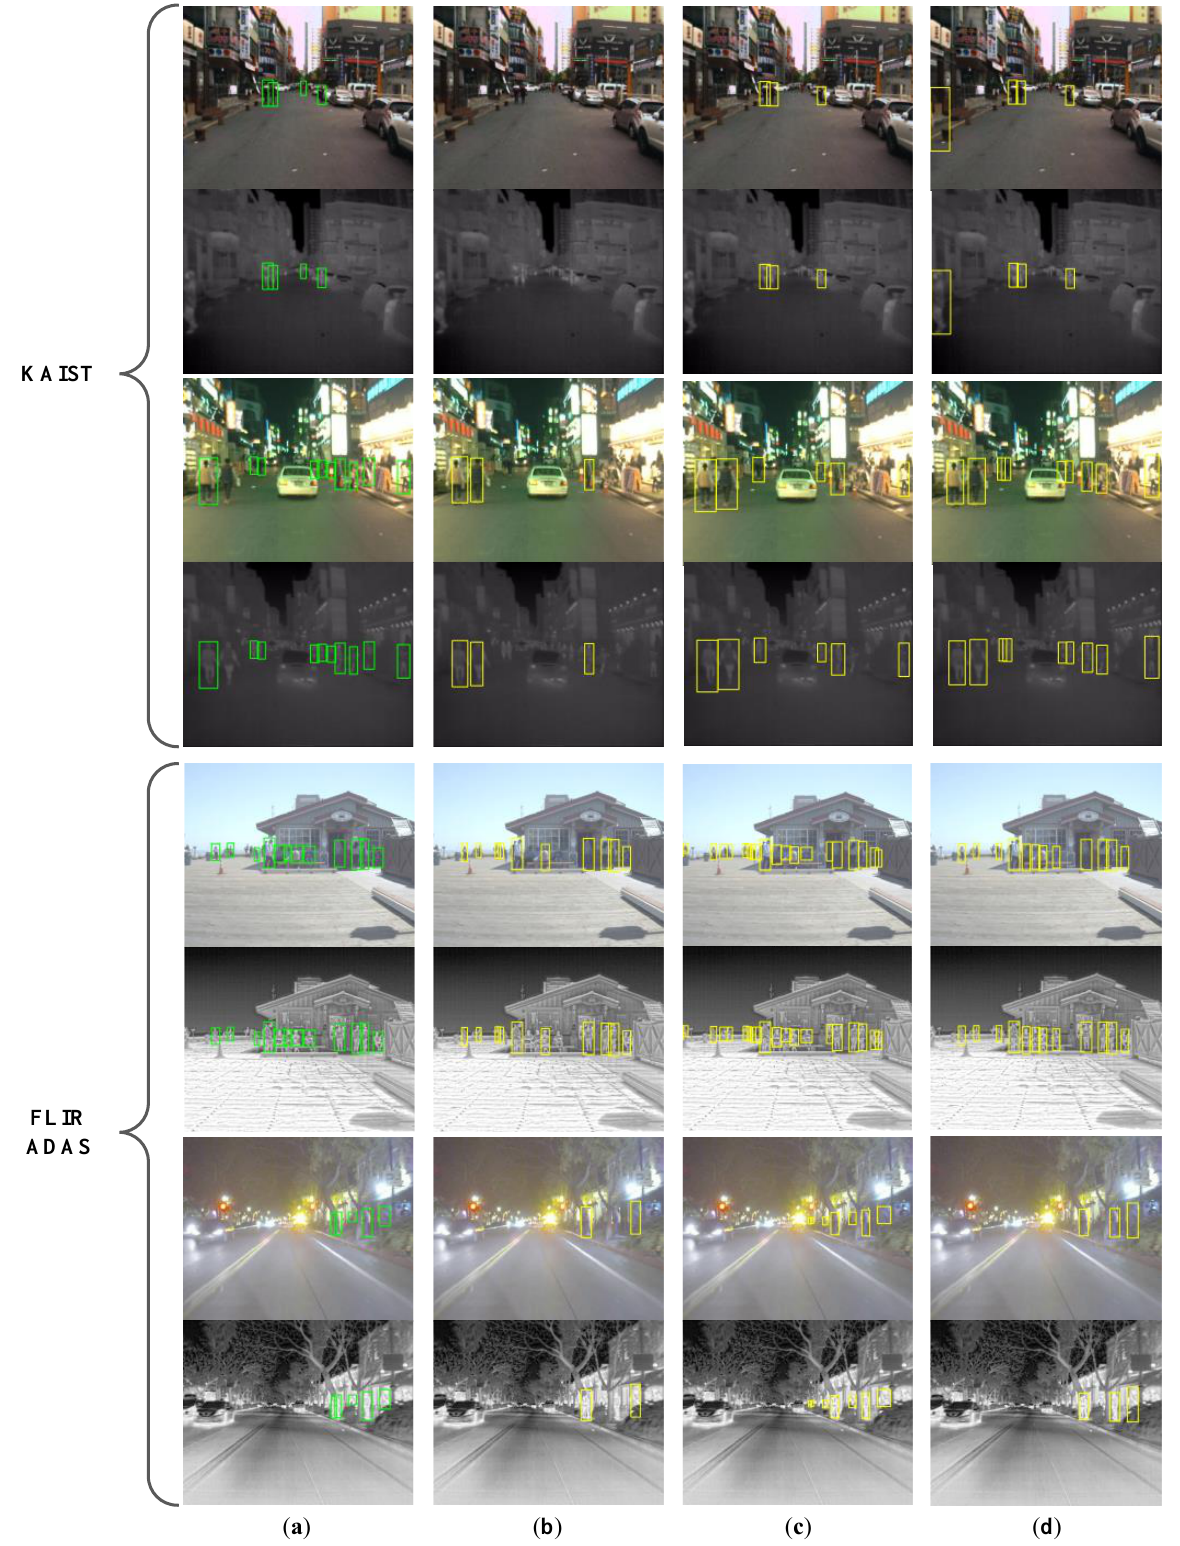
Figure 7. Examples of pedestrian detection results. ( a ) The ground truth. Detection results of the detector ( b ) trained only on CVC-14, ( c ) trained on the target dataset with manual annotations and ( d ) adapted from CVC-14 to the target dataset using our framework. The shown detections are test results from KAIST and FLIR ADAS datasets containing various illumination